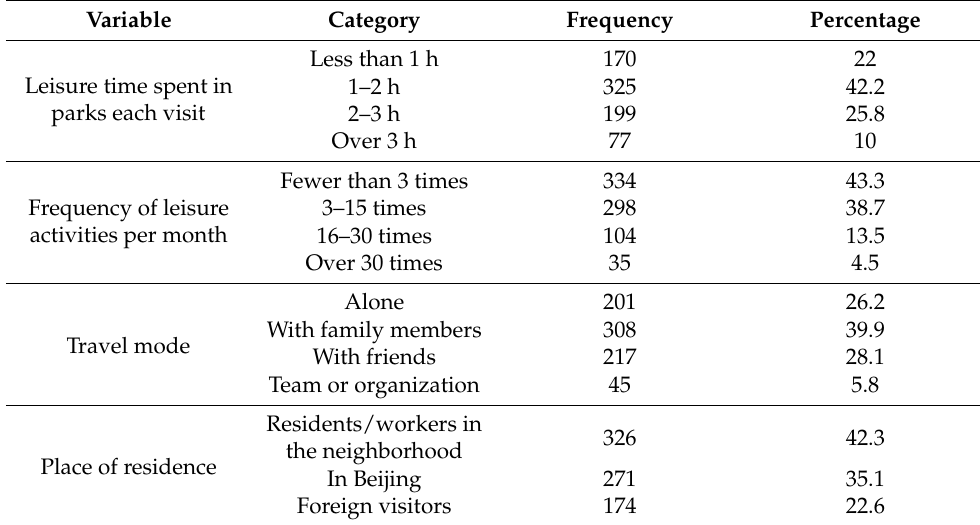
Table 2. Descriptive statistics of leisure behavior